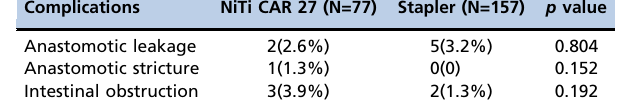
Table 3 - Comparison of the postoperative complications in two types of anastomotic devices. Complications